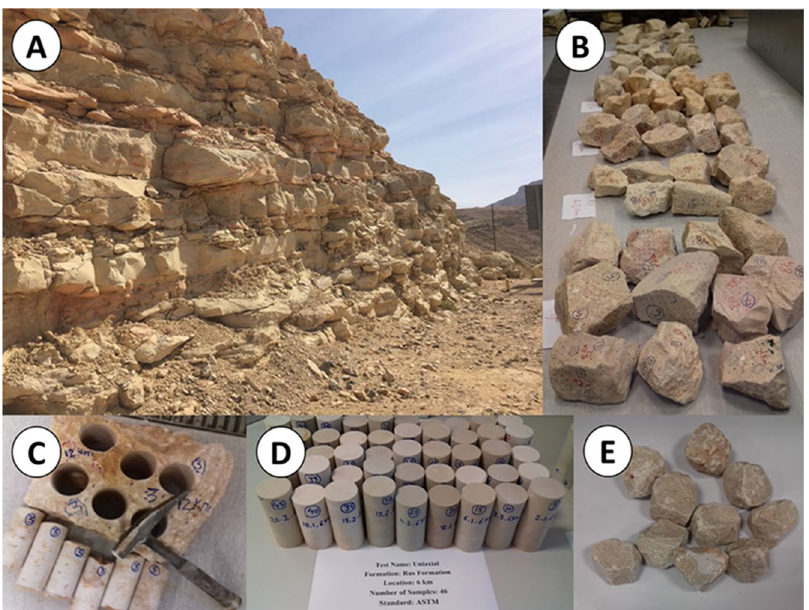
Figure 2. ( A ) General view of the Rus Formation and limestone outcrops, ( B ) a group of rock blocks collected from the field and used for coring and testing, ( C ) a cored rock block sample with core samples, ( D ) core samples prepared for the UCS test, and ( E ) test sample for the SDI test.